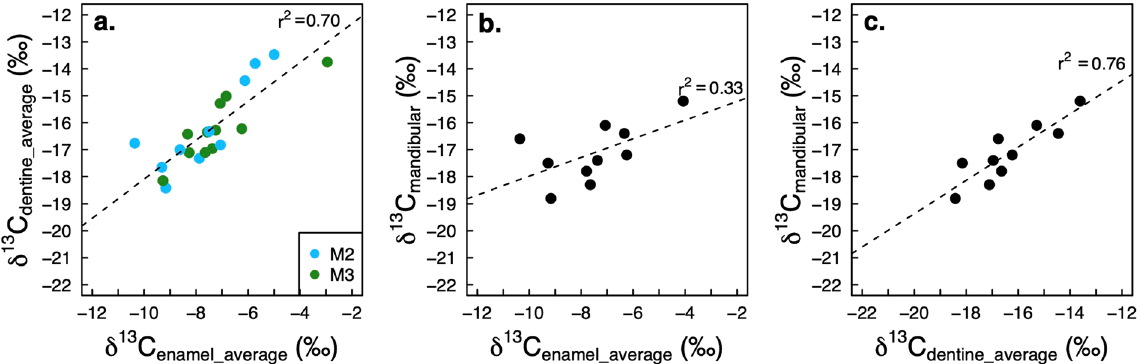
Figure 3. Linear correlations between the three δ 13 C proxies from each individual. ( a ) average δ 13 C enamel vs.